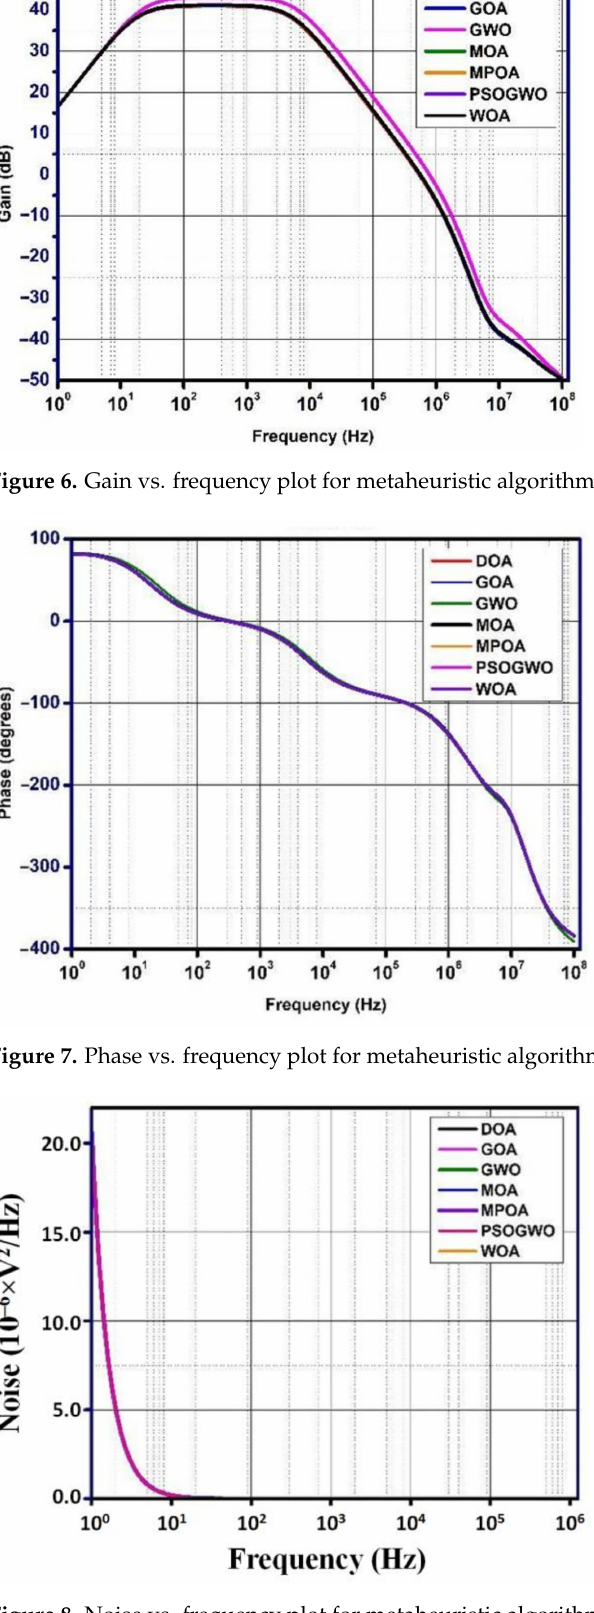
Figure 8. Noise vs. frequency plot for metaheuristic